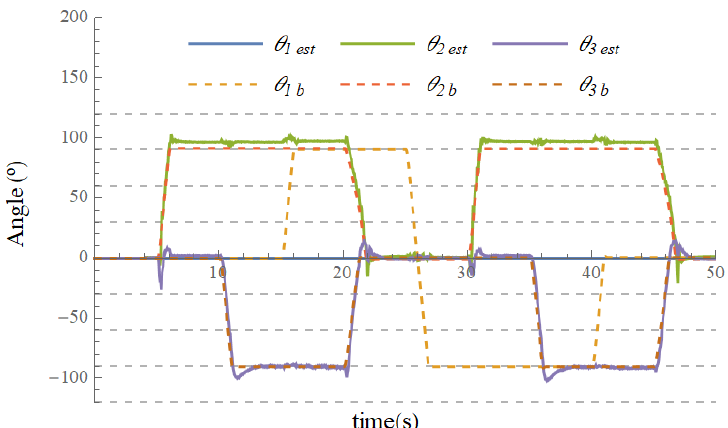
Figure 18. Evolution of estimates of the joints’ angles when testing the corrected joint model using accelerometer